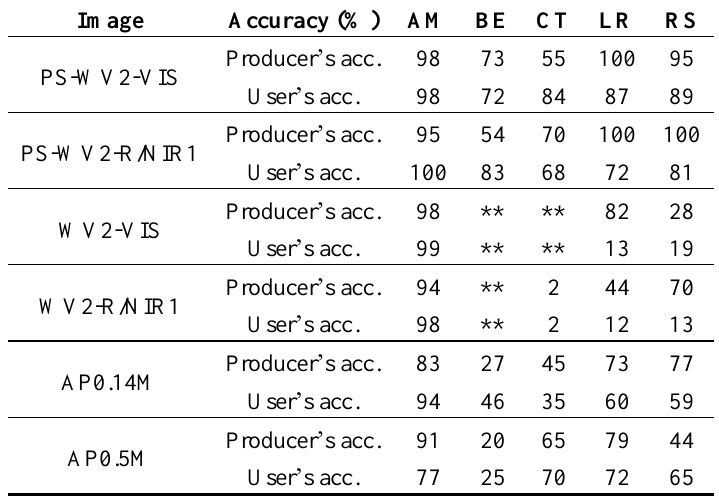
Table 4. Comparison of producer’s accuracy and user’s accuracy for each species,